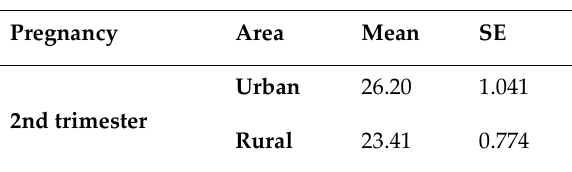
Table 2: Descriptive and statistical tests of pregnant women in the second trimester regarding age by